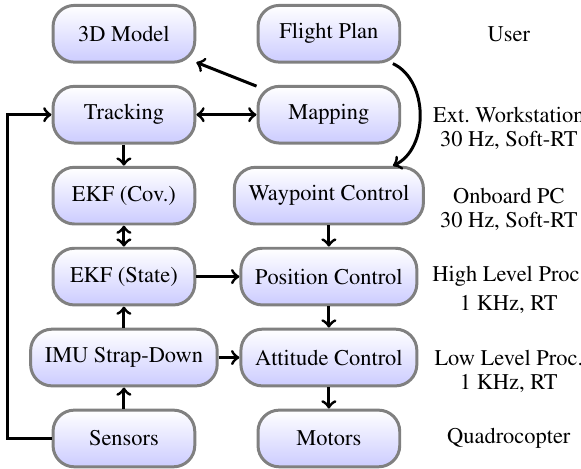
Figure 3: Control architecture used by our approach. The quadro- copter has three processors that operate at different cycle